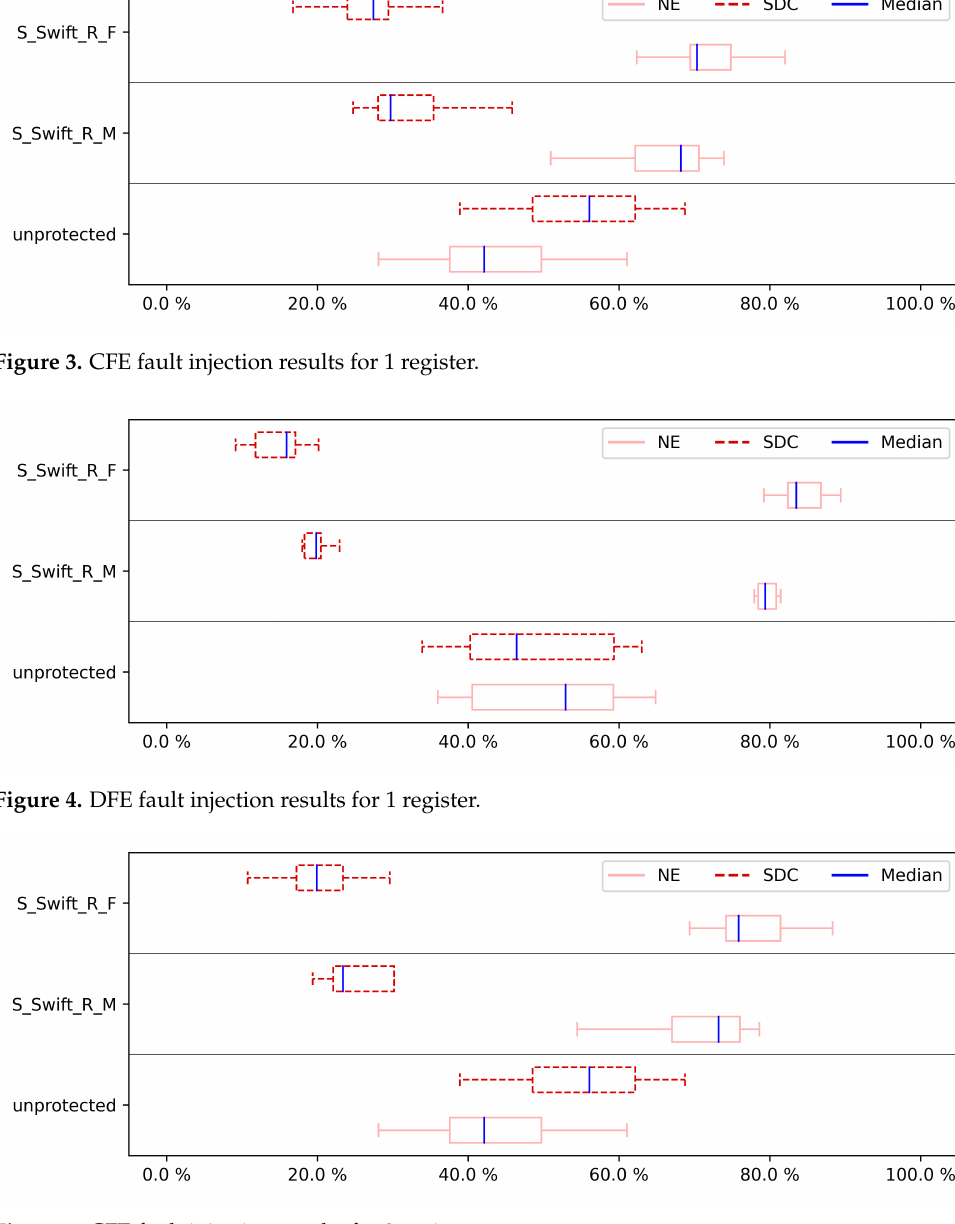
Figure 5. CFE fault injection results for 2